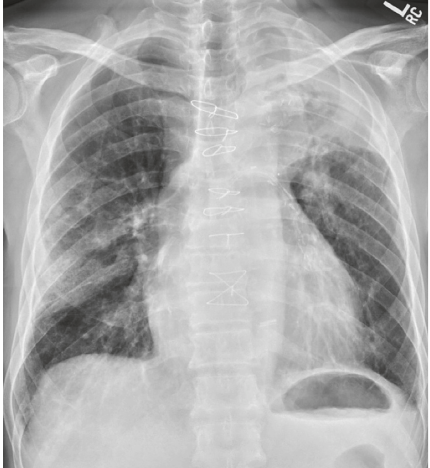
Figure 1: Chest radiograph on admission: multifocal pneumonia.